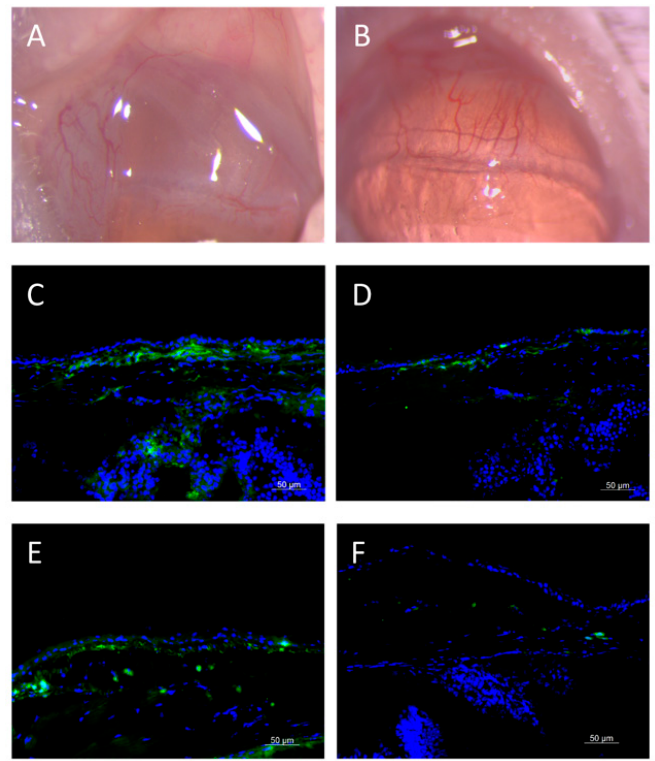
Figure 4. E ff ects of single-dose subconjunctival injection of liposomal tacrolimus for the treatment of allergic conjunctivitis in a mouse model. ( A ) On slit-lamp evaluation, mice with the induction of allergic conjunctivitis presented marked chemosis and congestion of conjunctival vessels, and ( B ) liposomal tacrolimus treatment reduced these signs. ( C – F ) On the immunohistochemistry staining, mice with allergic conjunctivitis exhibited significant expression of ( C ) IL-4 and ( E ) CD4, two cell markers for allergic reaction. ( D , F ) The expression of IL-4 and CD4 was less in the liposomal tacrolimus group,